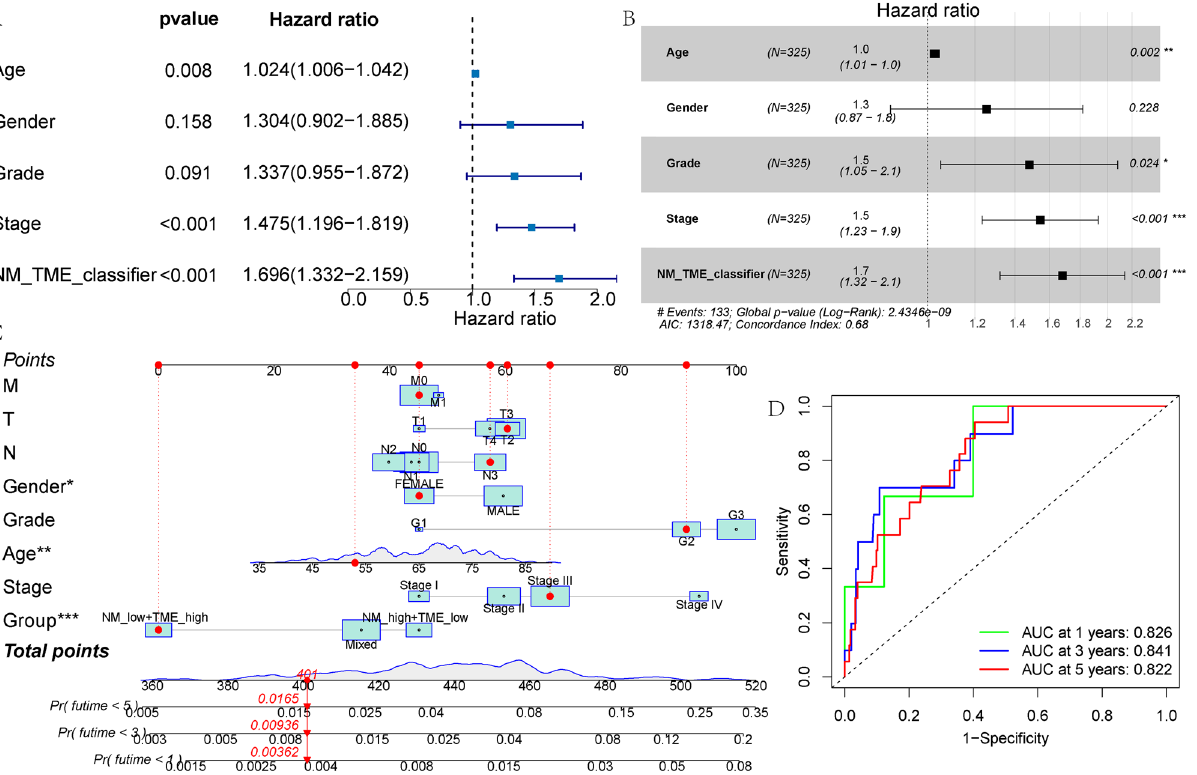
Figure 9. Construction of a nomogram. ( A , B ) Forest map of univariable and multivariable Cox regression in the test cohort. ( C ) Nomogram based on the NM-TME classifiers and clinical features. ( D ) Receiver operating characteristic (ROC) curves of the nomogram model in predicting the 1–5 years survival rate. NM nucleotide metabolism, TME tumour